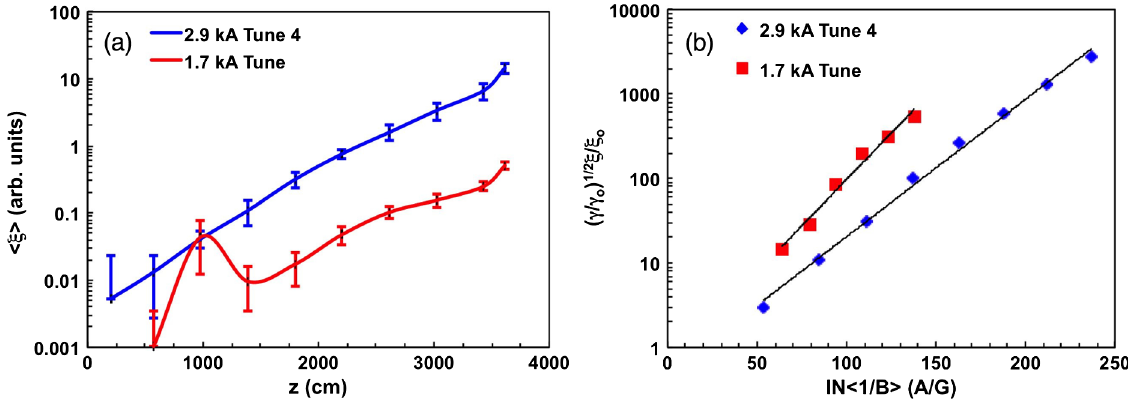
FIG. 6. (a) Increase of the average BBU amplitude h ξ i over five shots due to the increased beam current from 1.7 (red) to 2.9 kA (blue) and (b) comparison of BBU growth along the accelerator. Each tune indicates a constant transverse impedance.